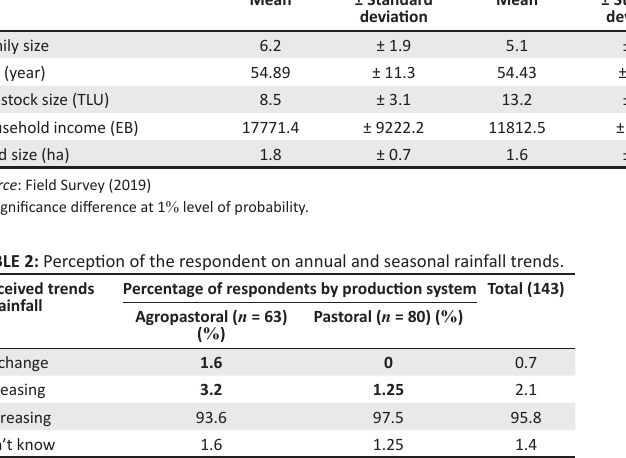
TABLE 1: Socioeconomic characteristics of respondents in continuous variables. Household characteristics